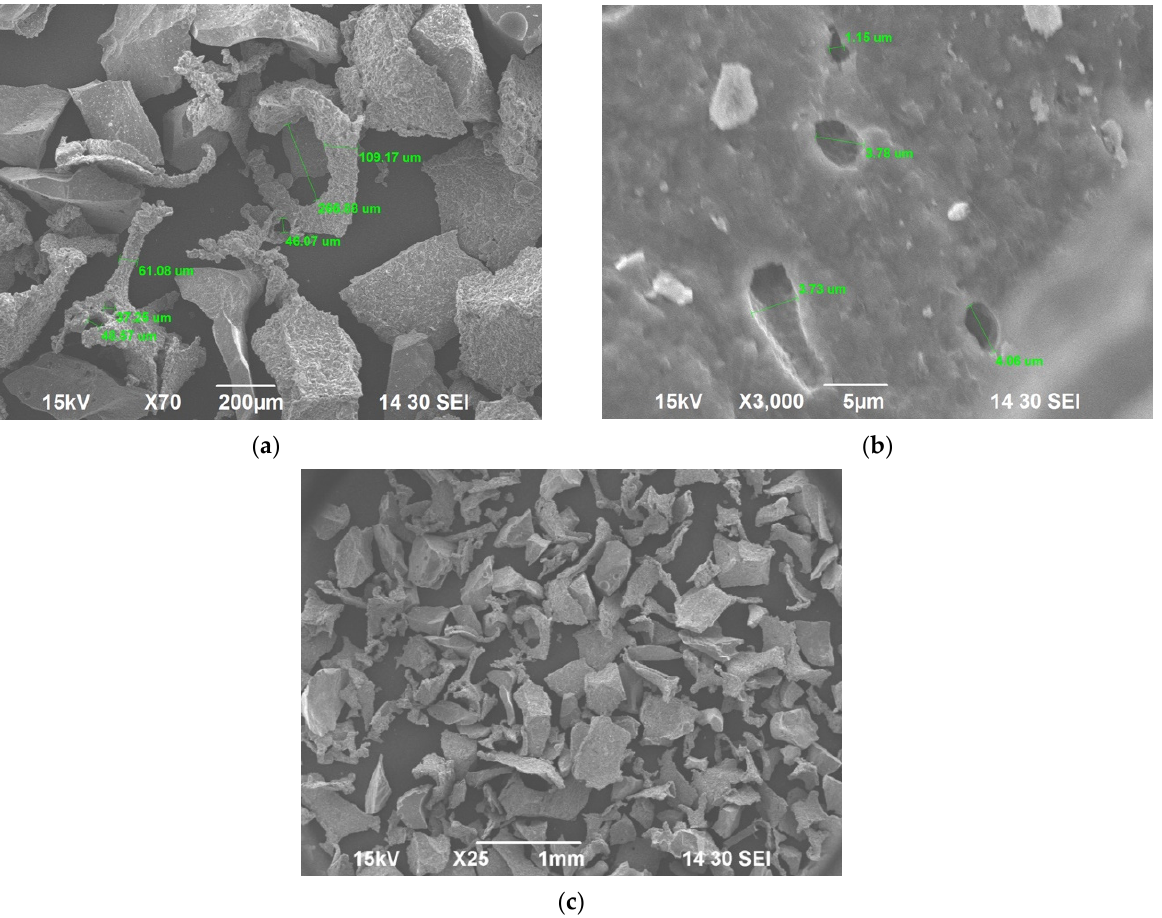
Figure 4. ( a ) SEM image of crushed BG. Struts of different width are seen; ( b ) The densified strut morphology and micropores are also visible on the struts. ( c ) Crushed BG particles. The green labels indicate strut and pore measurements.